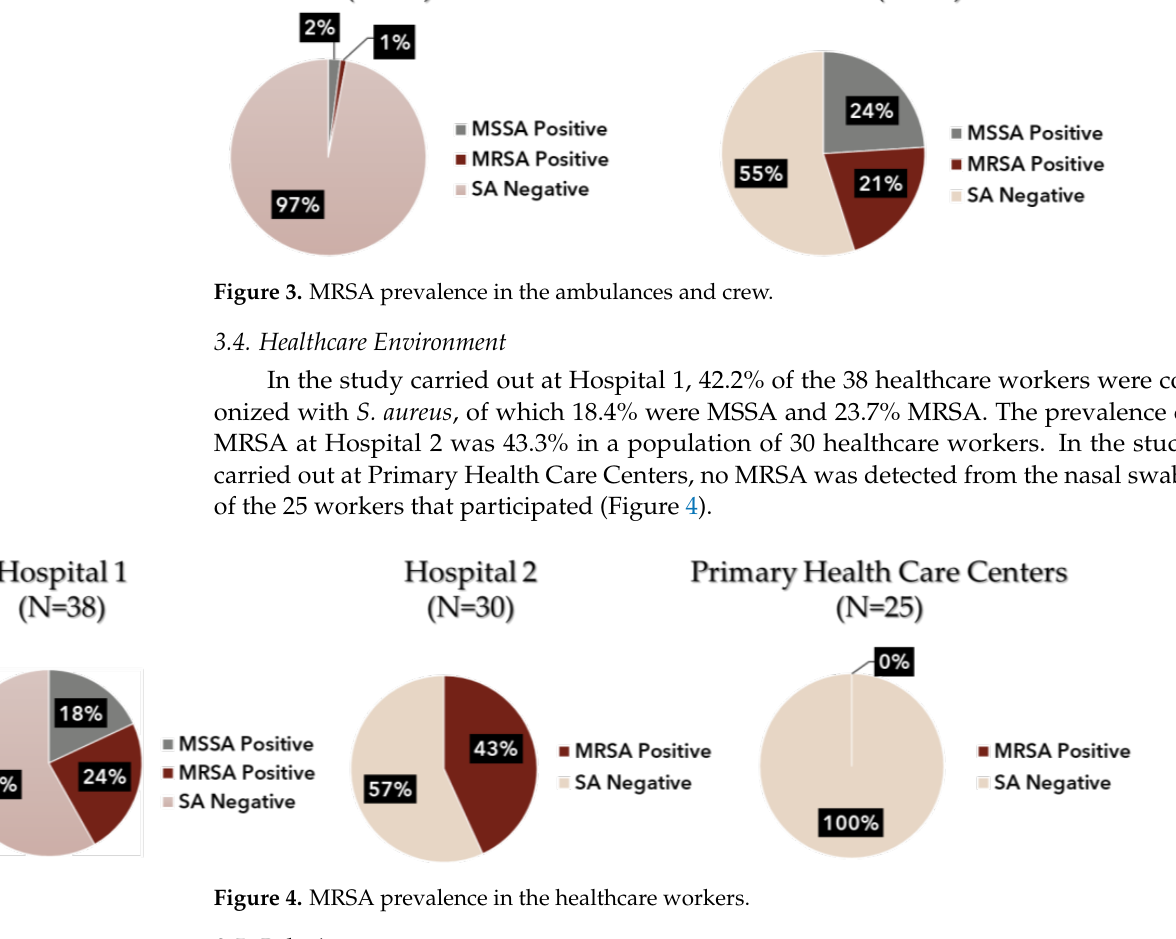
Figure 3. MRSA prevalence in the ambulances and crew .